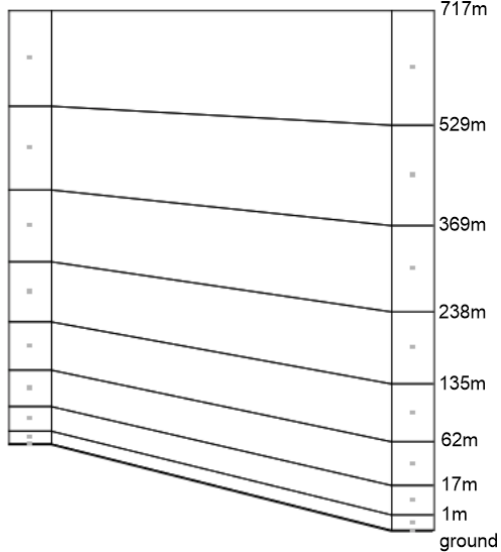
Figure 14. Schematic representation of the 3D vertical structure refined mesh generated by WindSim model. Eight vertical levels were considered to meet the convergence criteria of the CFD solver.